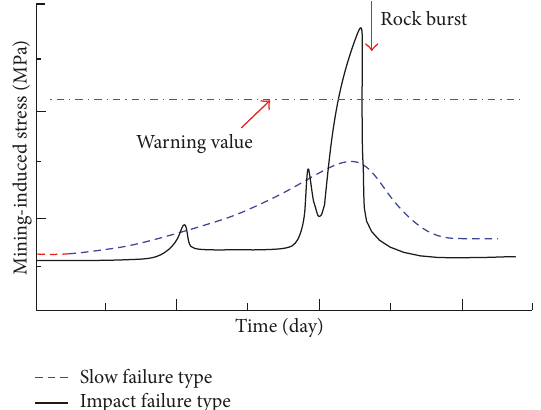
Figure 3: Change curve for mining-induced stress of fault-slip rock